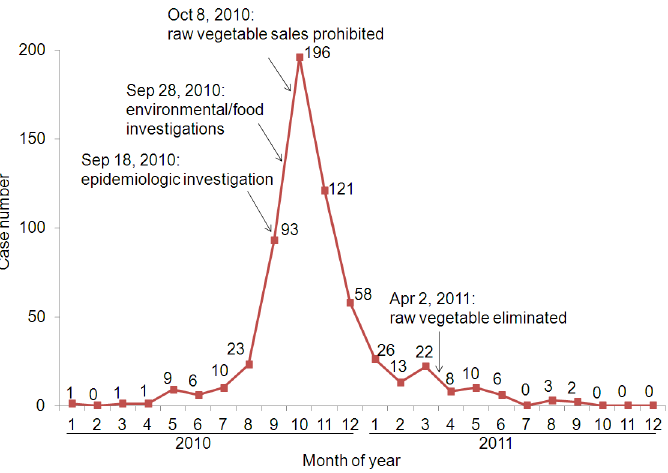
Fig 1. Paratyphoid fever cases reported by month during the outbreak in Yuanjiang. The times of the epidemiological investigations and two interventions are marked with arrows.